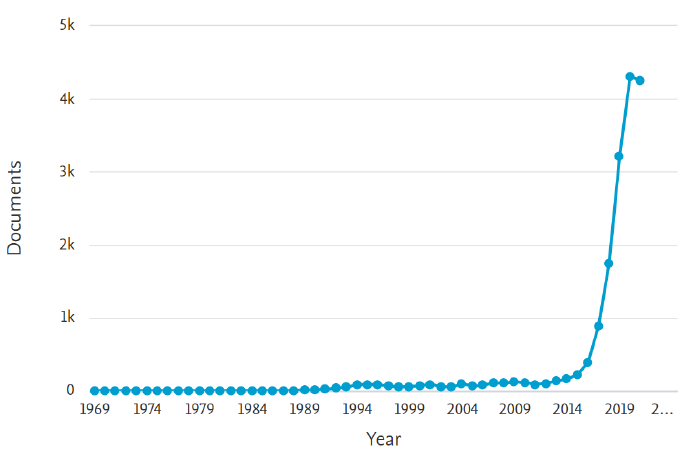
Figure 1. Number of documents per year related to the use of neural networks for fine-tuning or transfer learning, source